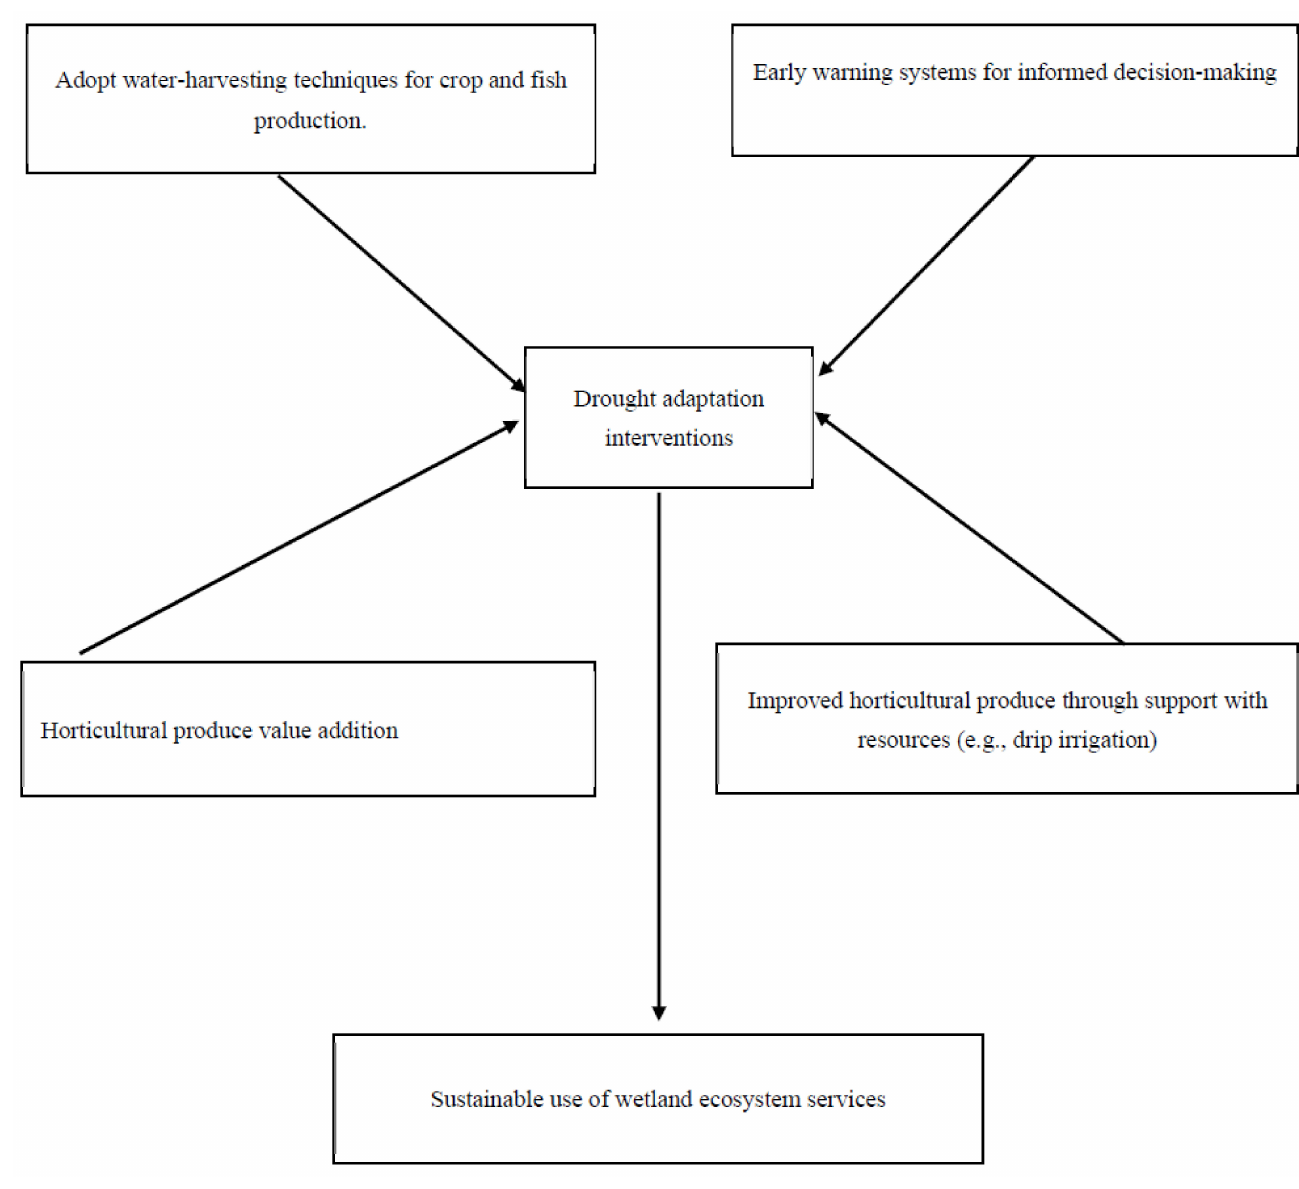
Figure 9. Proposed framework to enhance rural livelihood coping strategies in response to the impact of drought on wetland